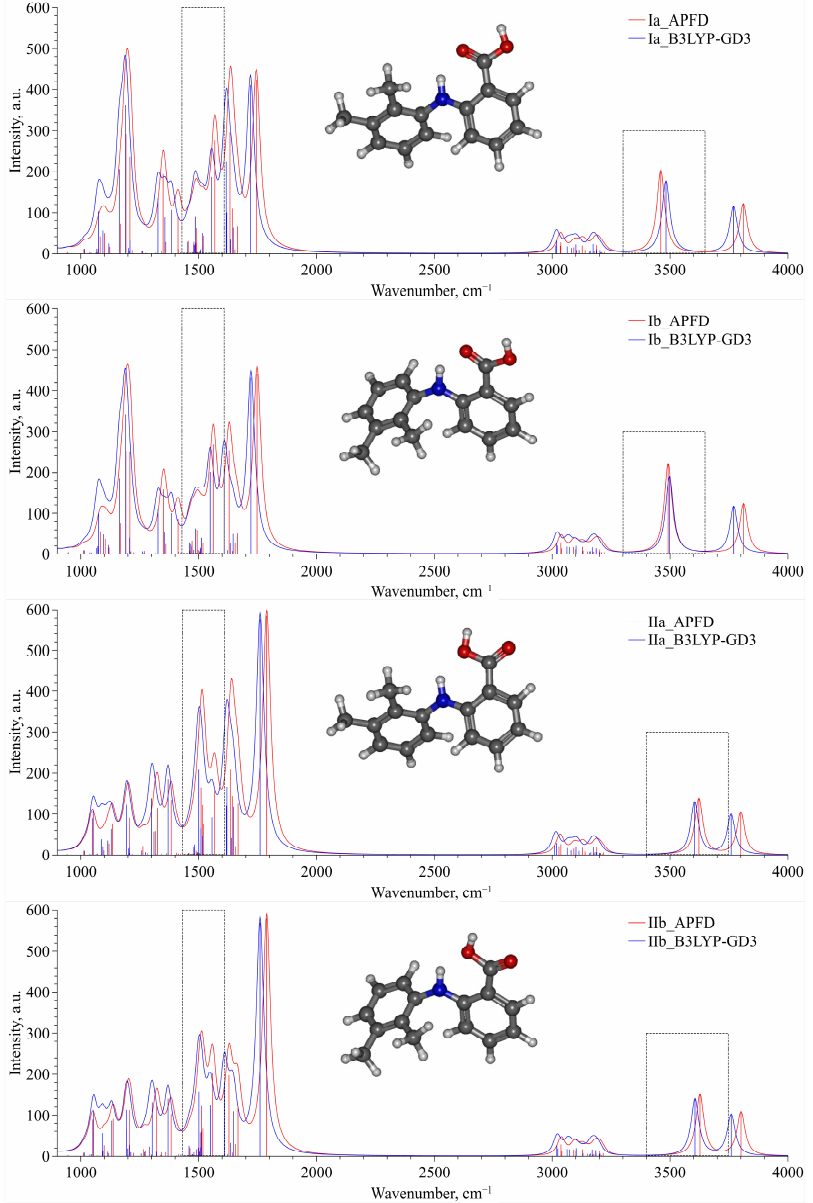
Figure 5. IR spectra for the four most stable conformers obtained within QCC using the B3LYP–GD3 and APFD functionals. The area bounded by dashed-line rectangles corresponds to the analytical spectral domains.